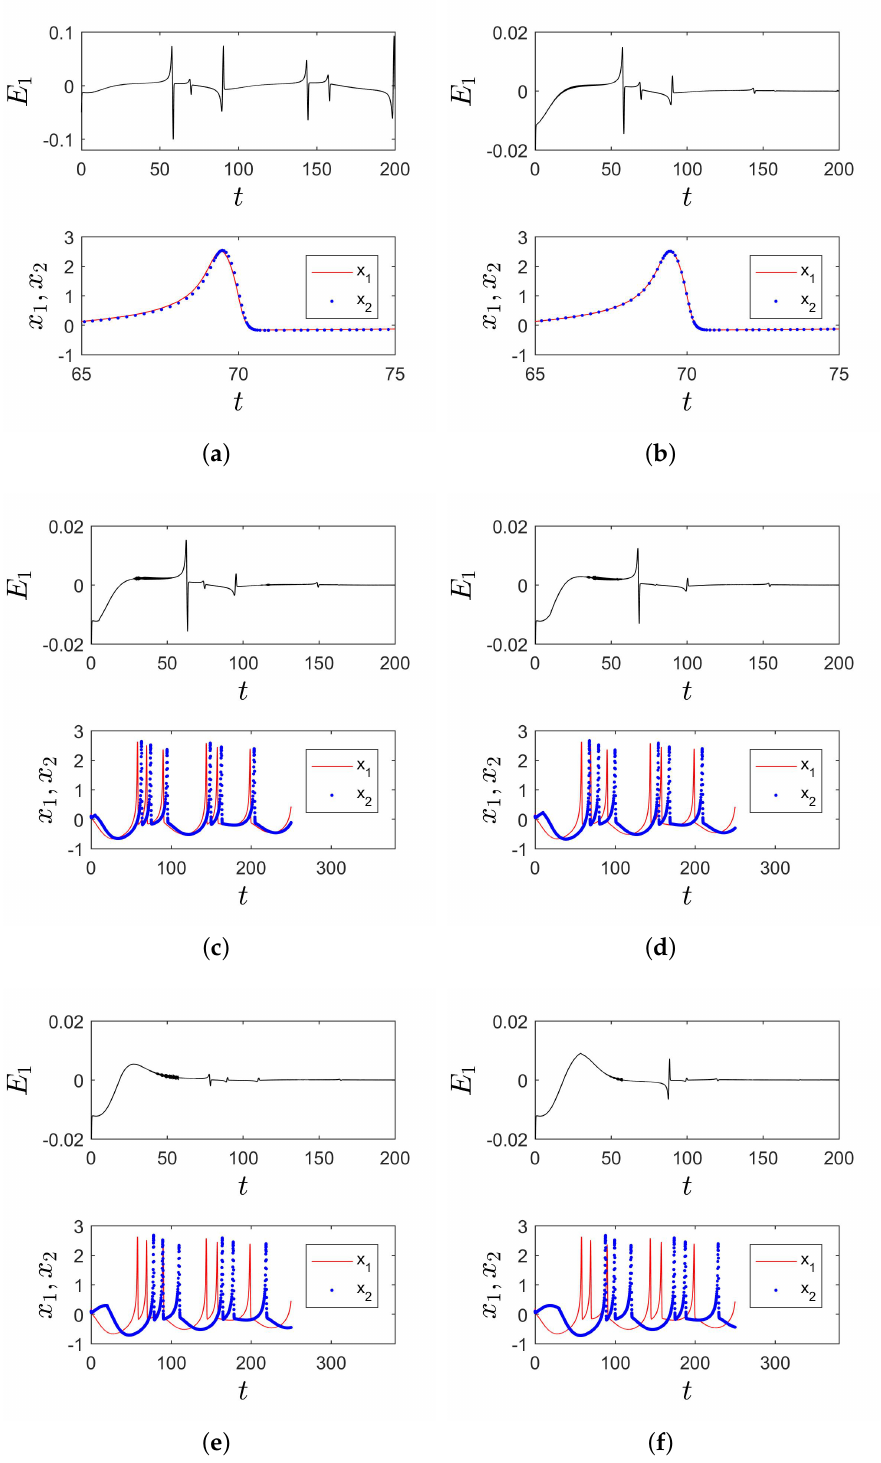
Figure 3. Synchronization errors and functional relation between x 1 and x 2 in System (27) with J ( x 1 ) = x 1 ( t − τ ) and ( a ) α = − 0.8, τ = 0, ( b ) α = − 1.3, τ = 0, ( c ) α = − 1.3, τ = 5, ( d ) α = − 1.3, τ = 10, ( e ) α = − 1.3, τ = 20, and ( f ) α = − 1.3, τ = 30. From Figure 4a,b,d,e, the functional relation x 2 = x 1 ( t − τ ) is reached between two HR neurons in System (27) with J ( x 1 ) = Q ( x 1 , y 1 , z 1 , τ ) for a small value of τ when α = − 1.3. When the value of τ increases (decreases) to τ = ± 0.5, the functional